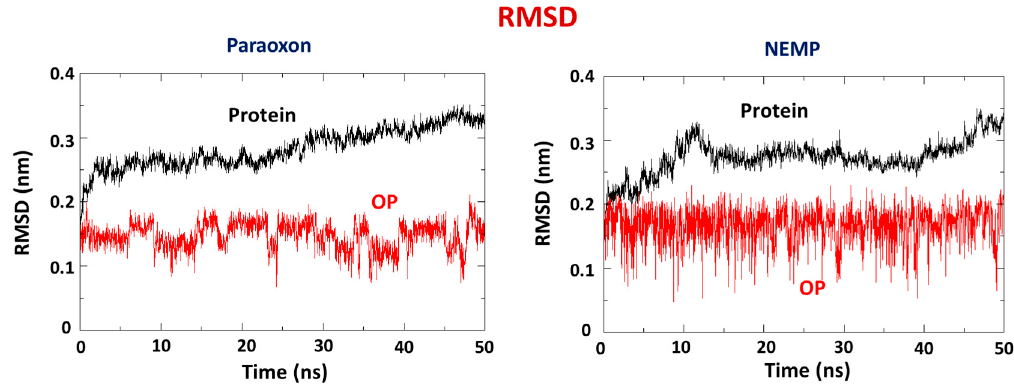
Figure 6. Root mean square deviation (RMSD) plots for PTE / PXN and PTE / NEMP during 50 ns of MD simulation.